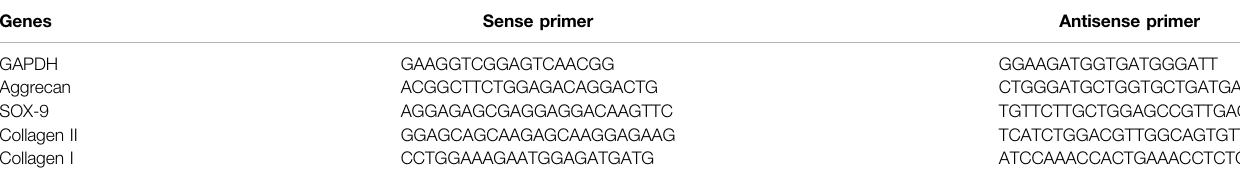
TABLE 2 | Primers used in qRT-PCR.